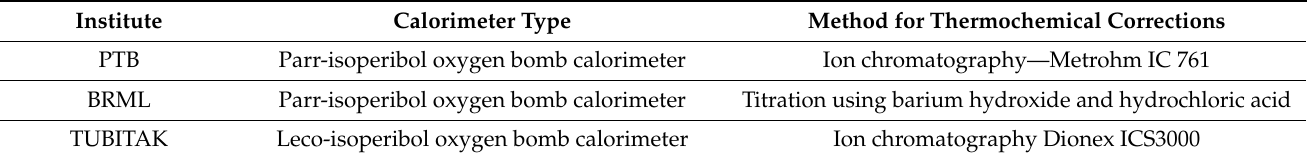
Table 1. Different instruments used in each laboratory for the calorific value